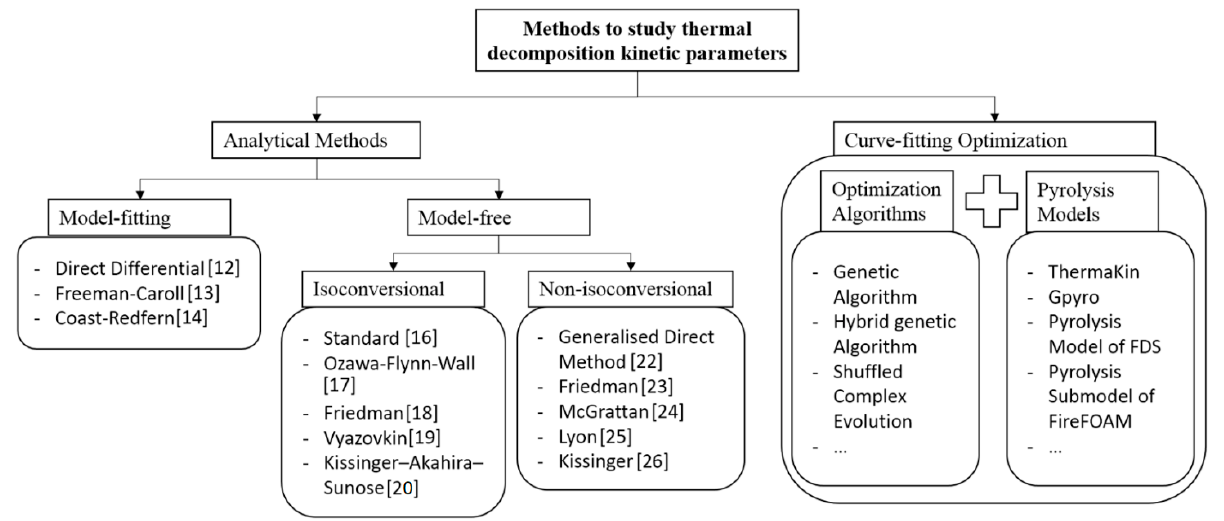
Figure 1. Methods developed to calculate kinetic decomposition parameters (adapted from [2]).